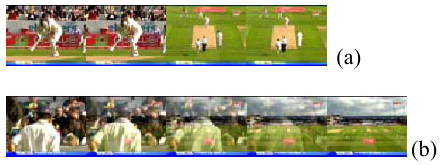
Figure 11 Shot transition detection (a) Cut (b)